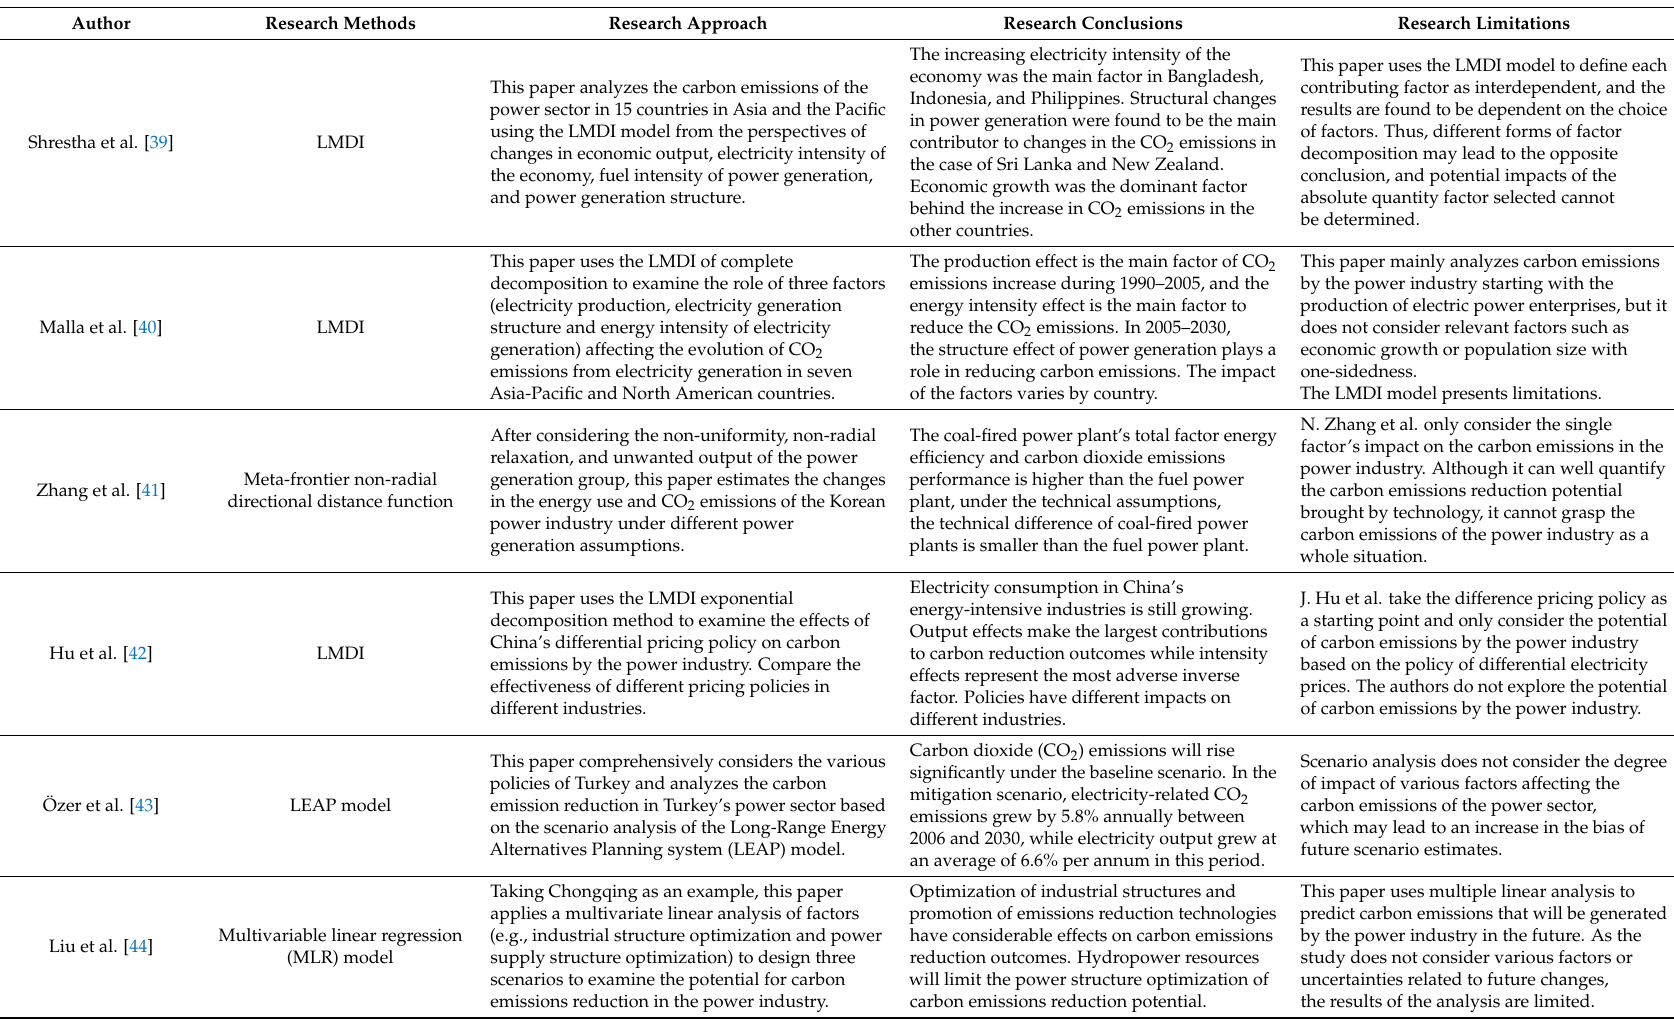
Table 2. Prior research on the carbon emissions by the power